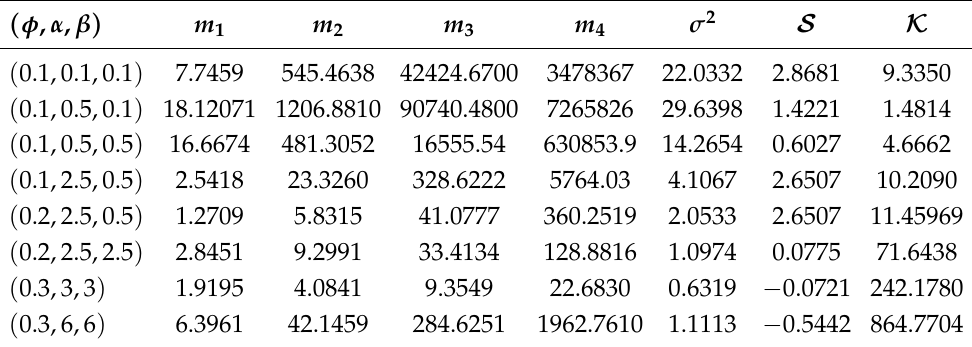
Table 2. Moments, variance, skewness, and kurtosis of the WOWE distribution for some parameter